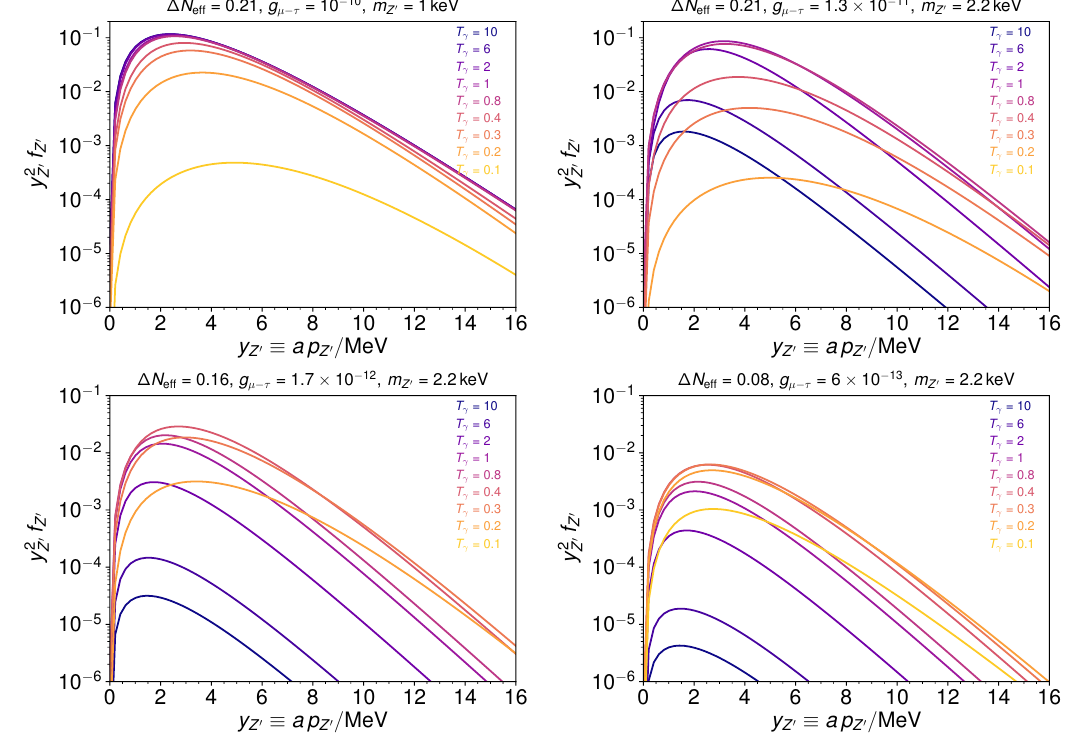
Figure 9 . In the upper panels, we plot the evolution of the Z 0 distribution function as a function of the photon temperature (in keV) for the two choices of masses and couplings considered in (cid:12)gure 7 which lead to (cid:1) N e(cid:11) = 0 : 21. The upper left panel corresponds to a Z 0 that thermalizes with the neutrinos while relativistic, while in upper right panel the Z 0 thermalizes with the neutrinos at T (cid:23) (cid:24) m Z 0 . In the lower panels, we plot the evolution of the Z 0 distribution as a function of the photon temperature for two scenarios in which the Z 0 never reaches thermal equilibrium with the neutrinos, leading to (cid:1) N e(cid:11) < 0 : 21.